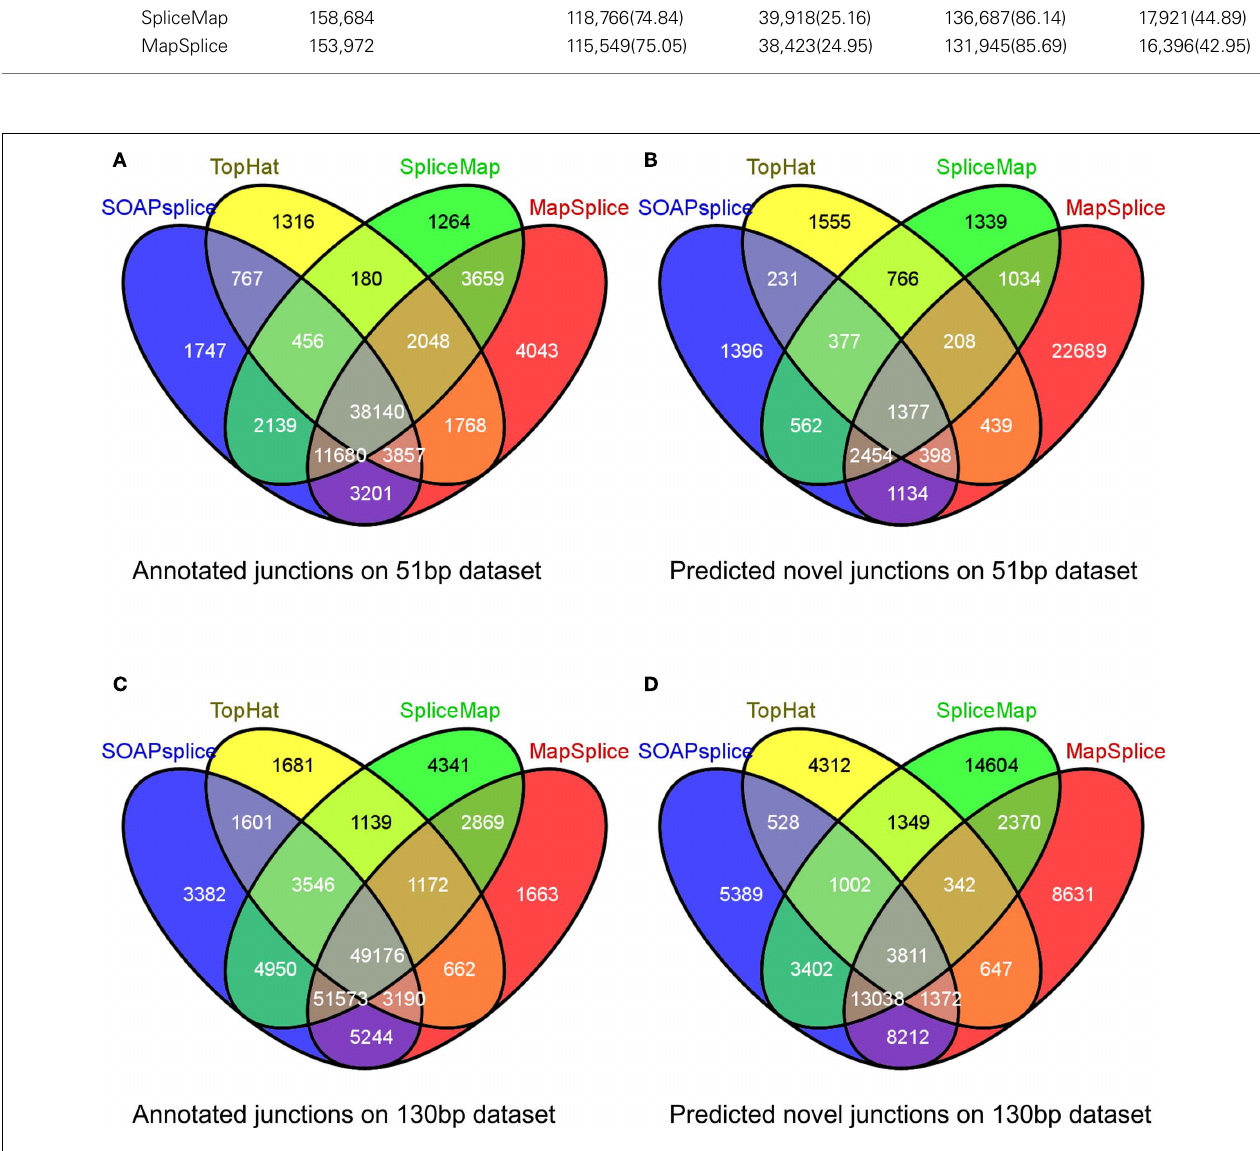
junctions. Numbers in different regions ofVenn diagrams describe junctions found by one or more than one tools.Venn diagram (A) andVenn diagram (B) represent the results of 51bp real dataset whileVenn diagram (C) andVenn diagram (D) represent the results of 130bp real dataset.